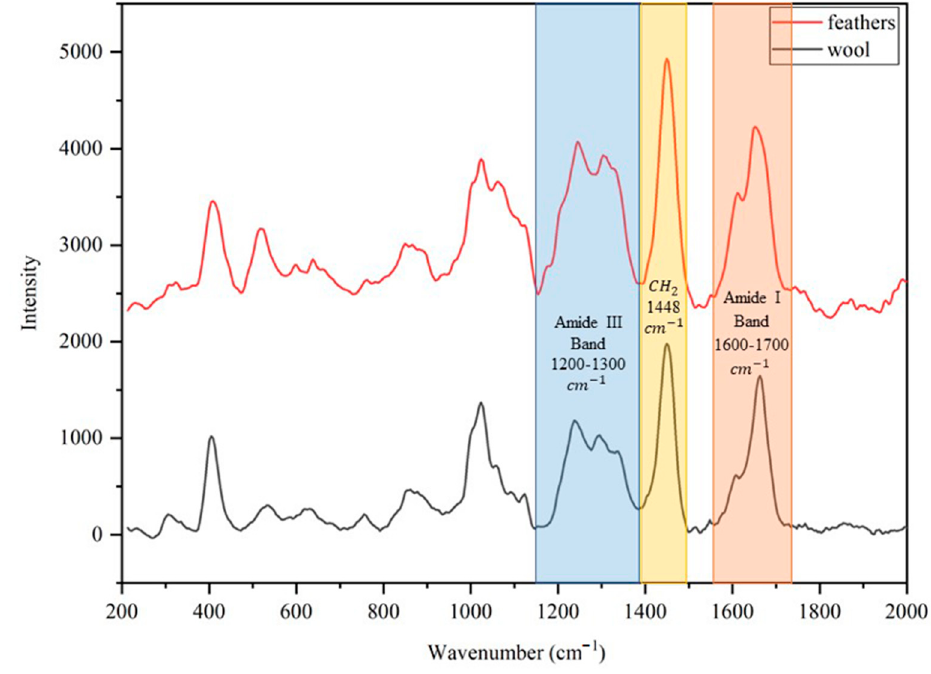
Figure 8. Comparison between the Raman spectrum of keratin extracted from wool (in black) and the spectrum of keratin extracted from feathers (in red).